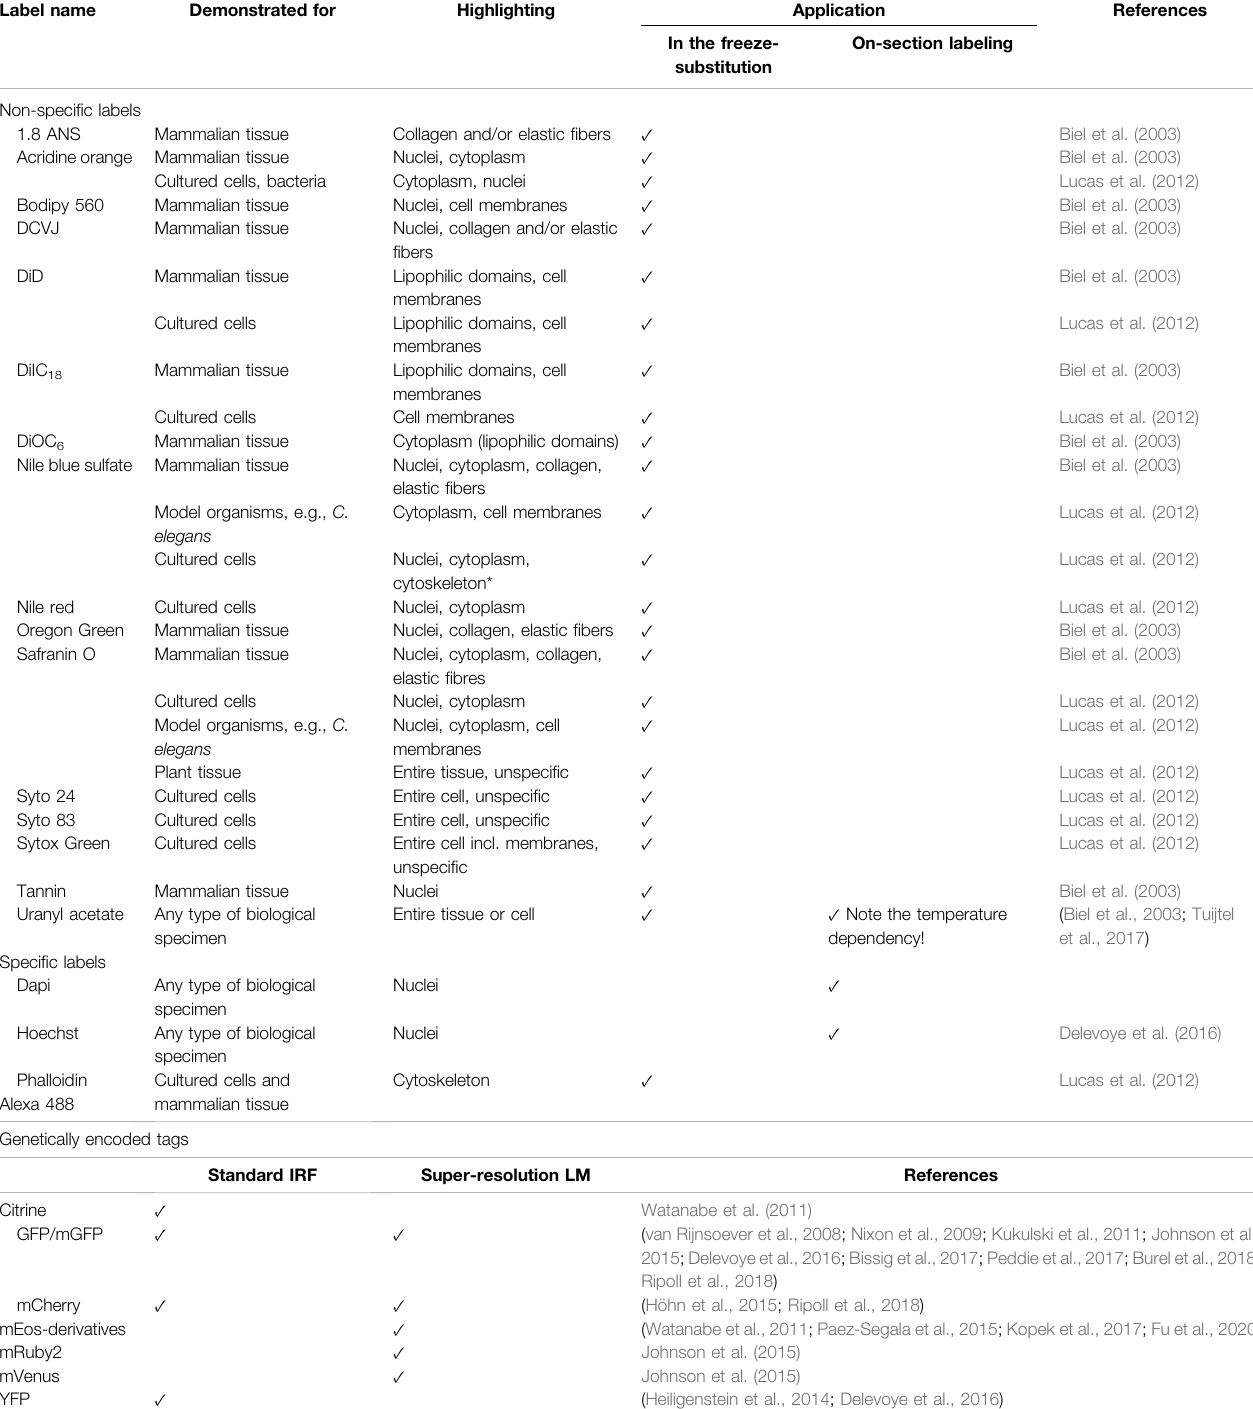
TABLE 1 | Fluorescent labels for IRF.